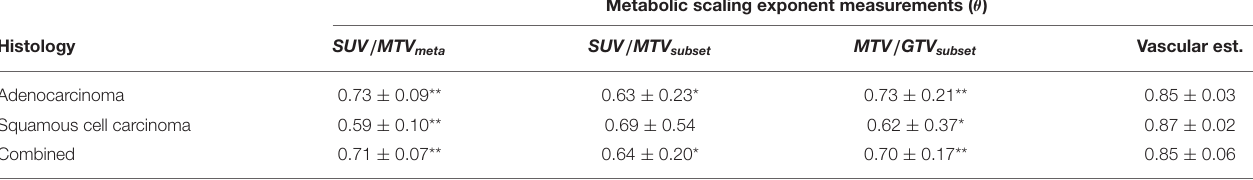
Metabolic scaling exponent measurements ( θ